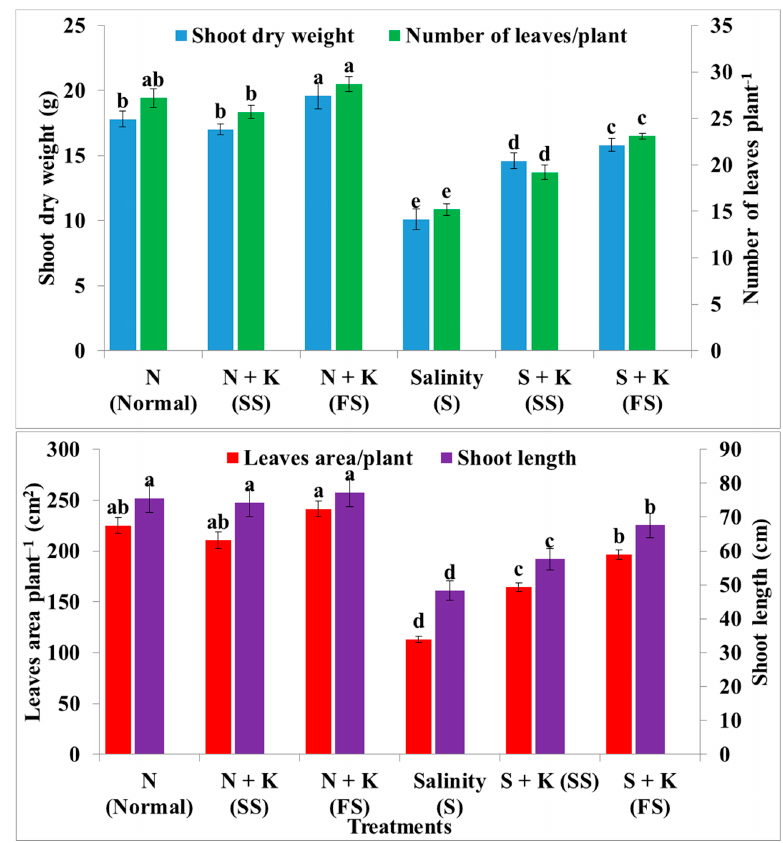
Figure 1. Effect of seed soaking (SS) and foliar spray (FS) of potassium (6 mM K 2 SO 4 ) on growth traits of soybean plants grown under normal (EC = 2.68 dS m − 1 ) and salt stress (EC = 7.46 dS m − 1 ) conditions. Means followed by the same letter in each parameter are not significantly different according to the least significant differences (LSD) test ( p ≤ 0.05). Error bars are ± Standard Error (SE). Except for a significant increase in total chlorophyll content by FS of potassium, total chlorophylls, total carotenoid contents and performance index (PI, %) were not affected by potassium applied as SS or FS to normal soil compared to the control (Figure 2). Under a salinity level of 7.46 dS m − 1 , total chlorophylls, carotenoids contents and the PI% were significantly decreased compared with the control. Nevertheless, FS or SS with potassium significantly increased these photosynthetic parameters, with a preference for FS, compared with the control (Figure 2). FS with potassium was the most effective treatment, increasing the total chlorophyll content by 184.5%, total carotenoids by 20% and the PI by 43.8% compared with the control. Under salt stress, the impact of potassium on soybean photosynthetic parameters was evident compared with normal conditions. At 2.68 ds m salinity, FS with potassium was found to exceed SS and increased K